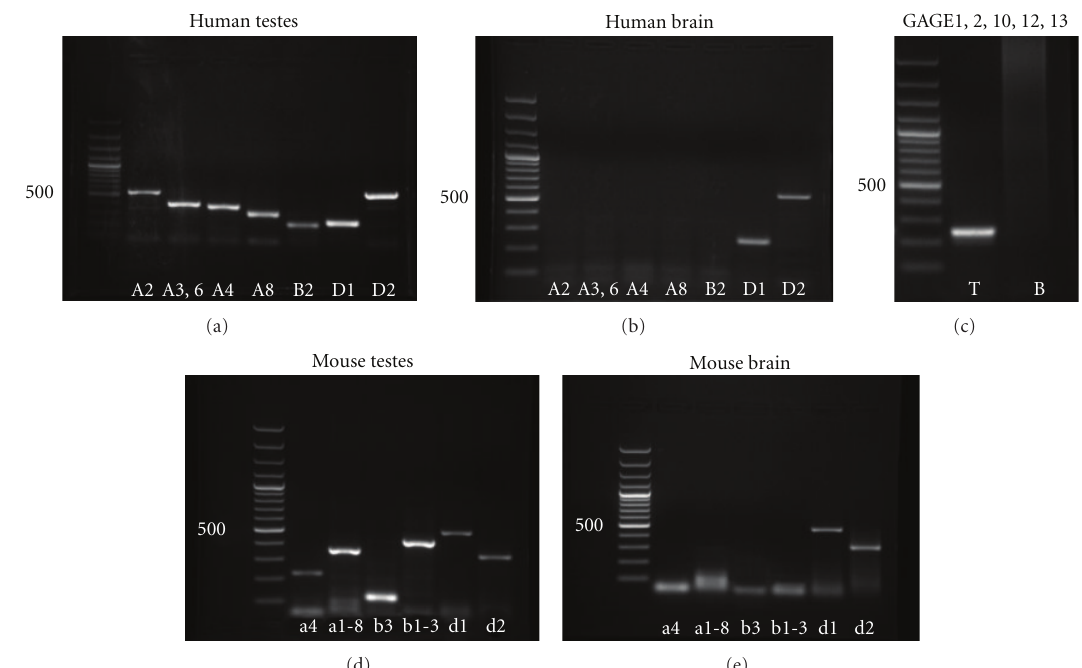
Figure 1: CTA expression in adult human and mouse testicular and brain samples. Designations: T: human testes, B: human brain.